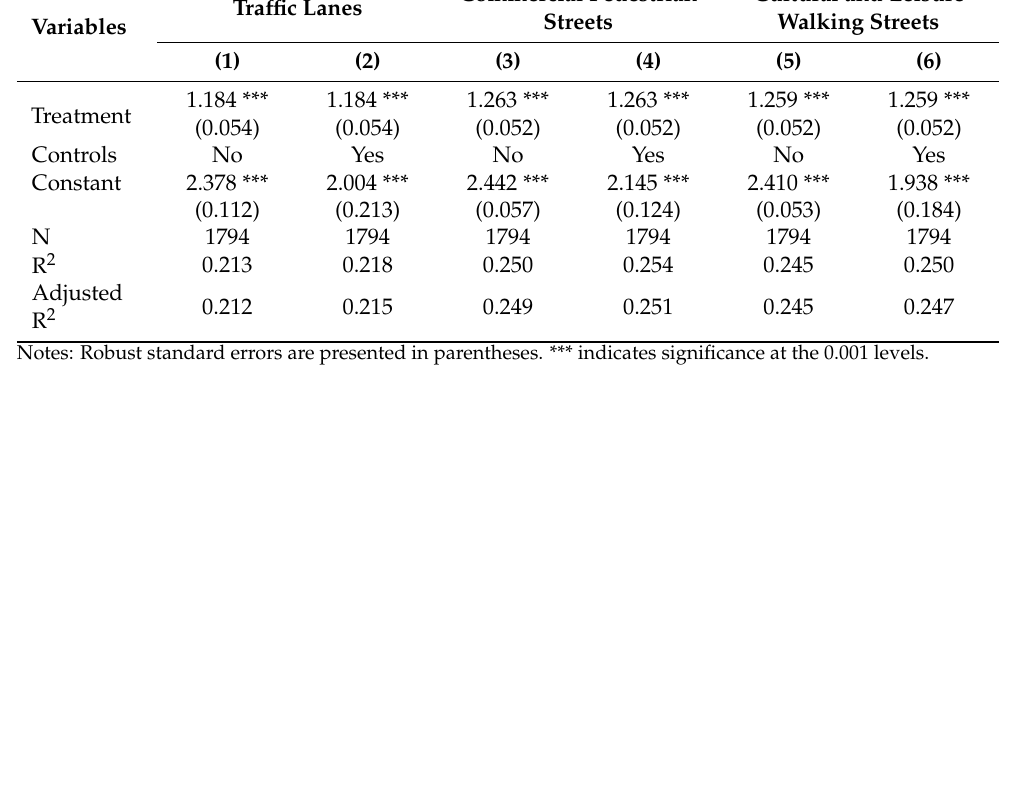
Table A5. The effect of the three types of streets on tourists’ arousal.